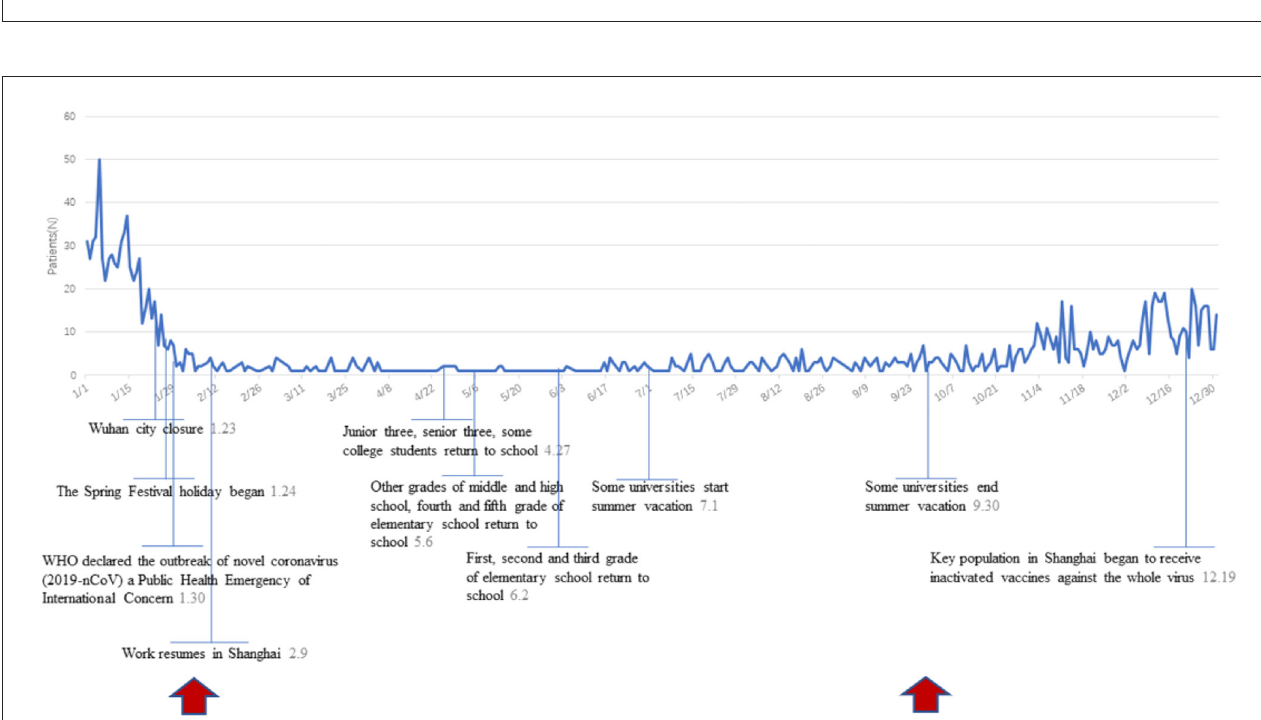
FIGURE2 Number of AOM outpatients monthly in Non-pandemic and COVID-19 Pandemic Period (2015–2020).